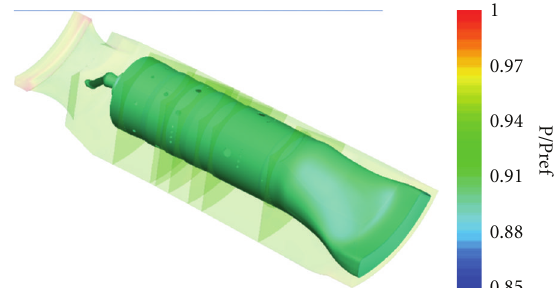
Figure 13: Combustor can pressure contours at cruise.